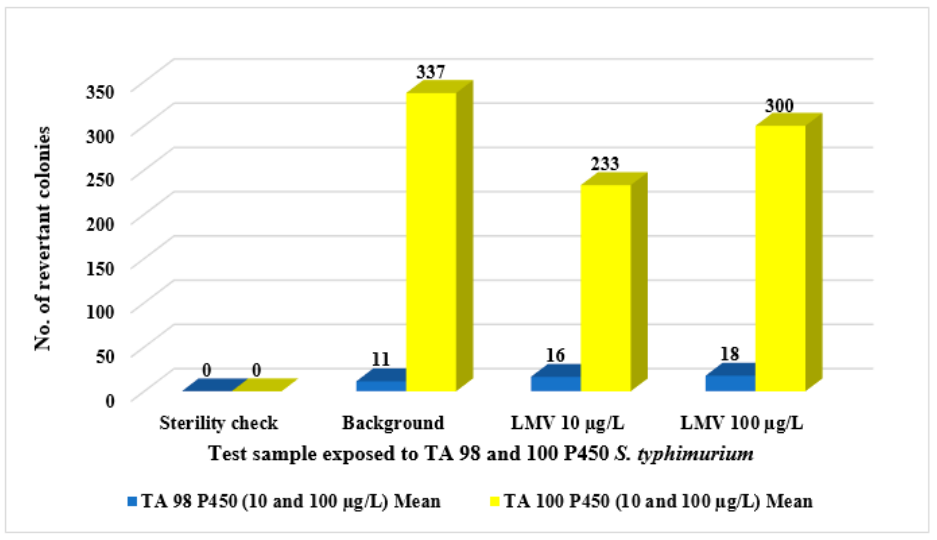
Figure 4. Ames Salmonella mutagenicity test: comparison between responses of TA 98 P450 and TA 100 P450 bacterial strains to lamivudine test samples.